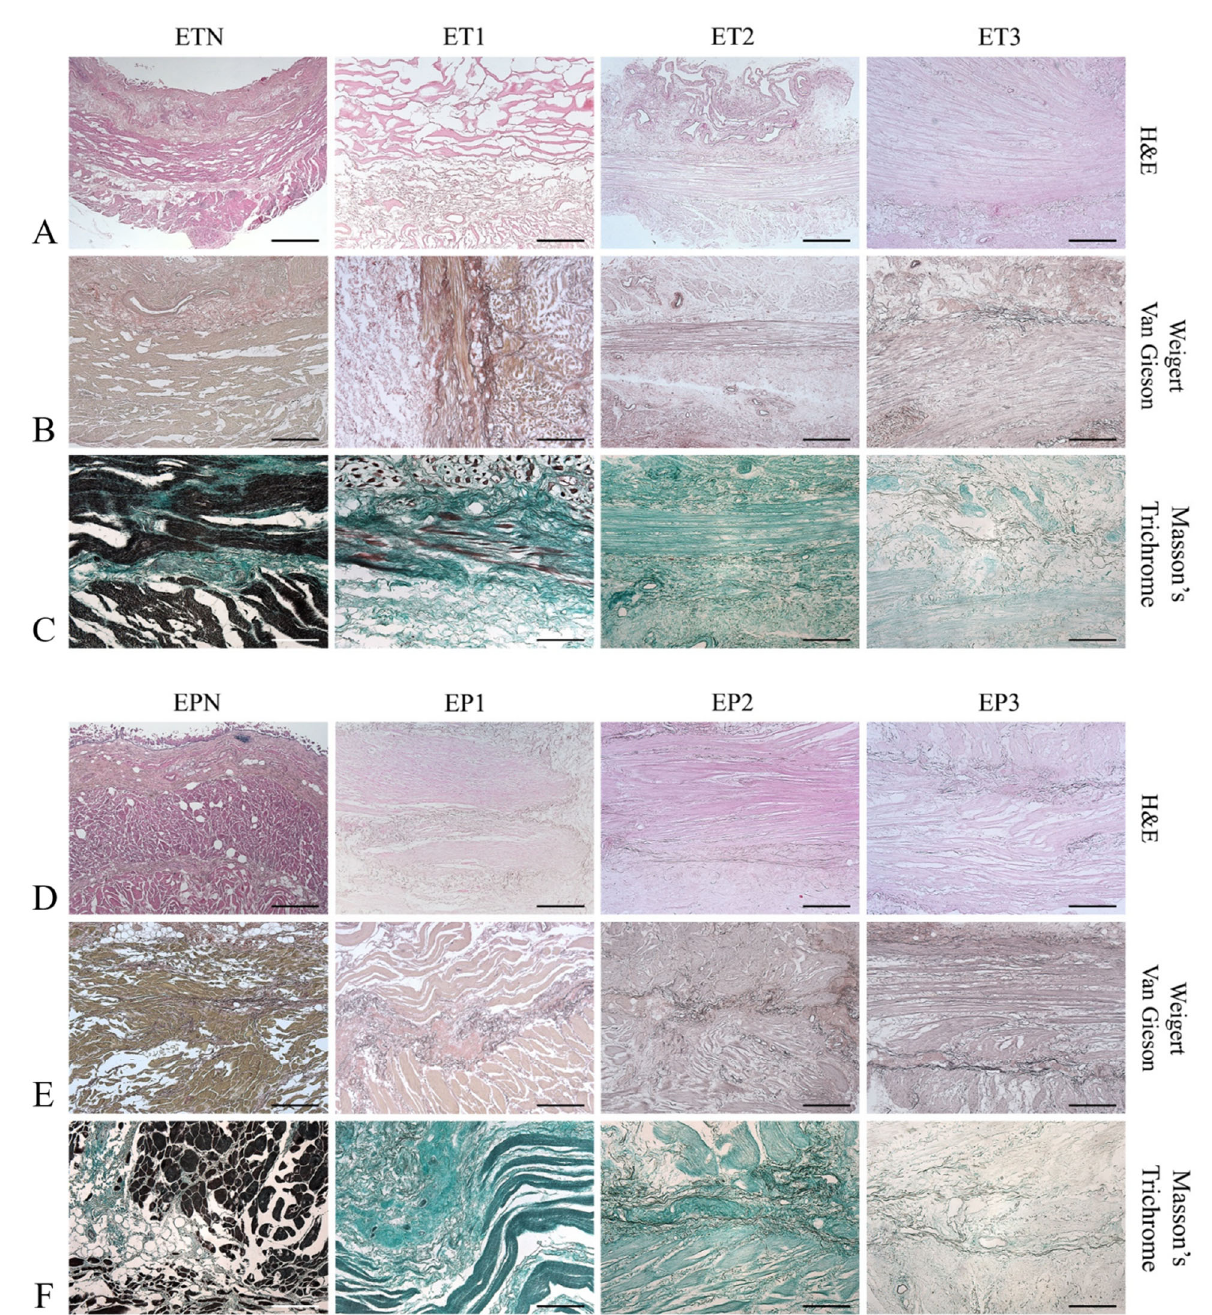
Figure 2. Microscopic structure of decellularized esophagi. Histological evaluation of esophageal tubules (ETs) and patches (EPs) before (ETN, EPN) and after decellularization with Protocols Nos. 1 (ET1, EP1), 2 (ET2, EP2) and 3 (ET3, EP3). Scale bars: 800 μ m (( A , D ) ETN, EPN); 400 μ m ( A , B , D , E ); 200 μ m ( C , F ).